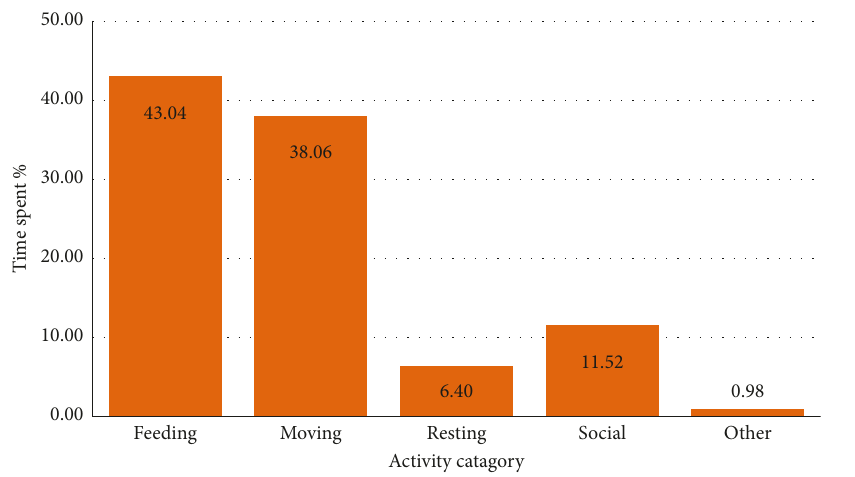
Figure 2: Activity time budget of geladas.